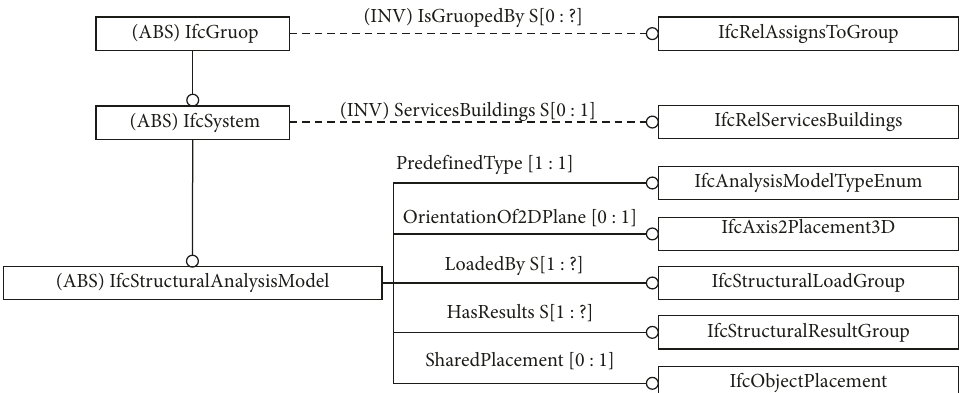
Figure 24: Properties of IfcStructuralAnalysisModel.